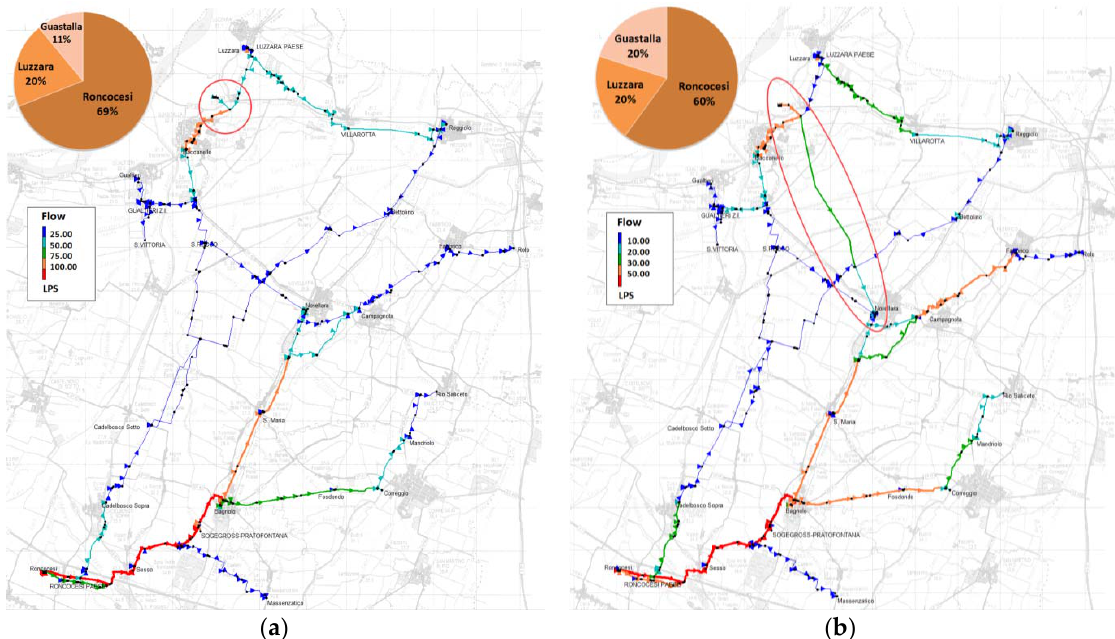
Figure 3. ( a ) Alternative strategy in order to decrease water withdrawals from Roncocesi well field of 14% (Strategy 1); ( b ) Alternative strategy in order to reduce water withdrawals from Roncocesi well field of 26% (Strategy 2). For both interventions, the percentage of distributed water by each aqueduct is